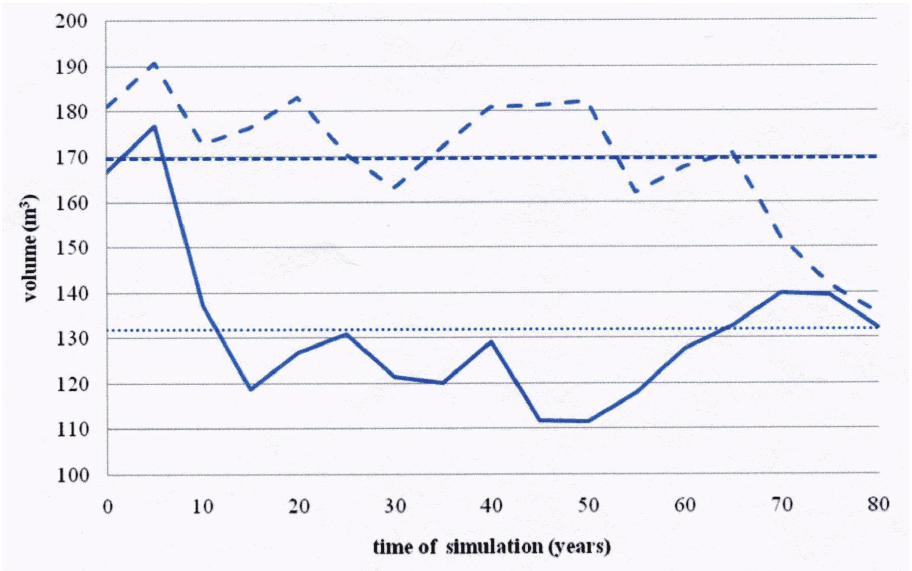
Figure 7. Prediction of time changes in tree diameter diversity (cm) of the beech stands in study site Jeleni Bucina.